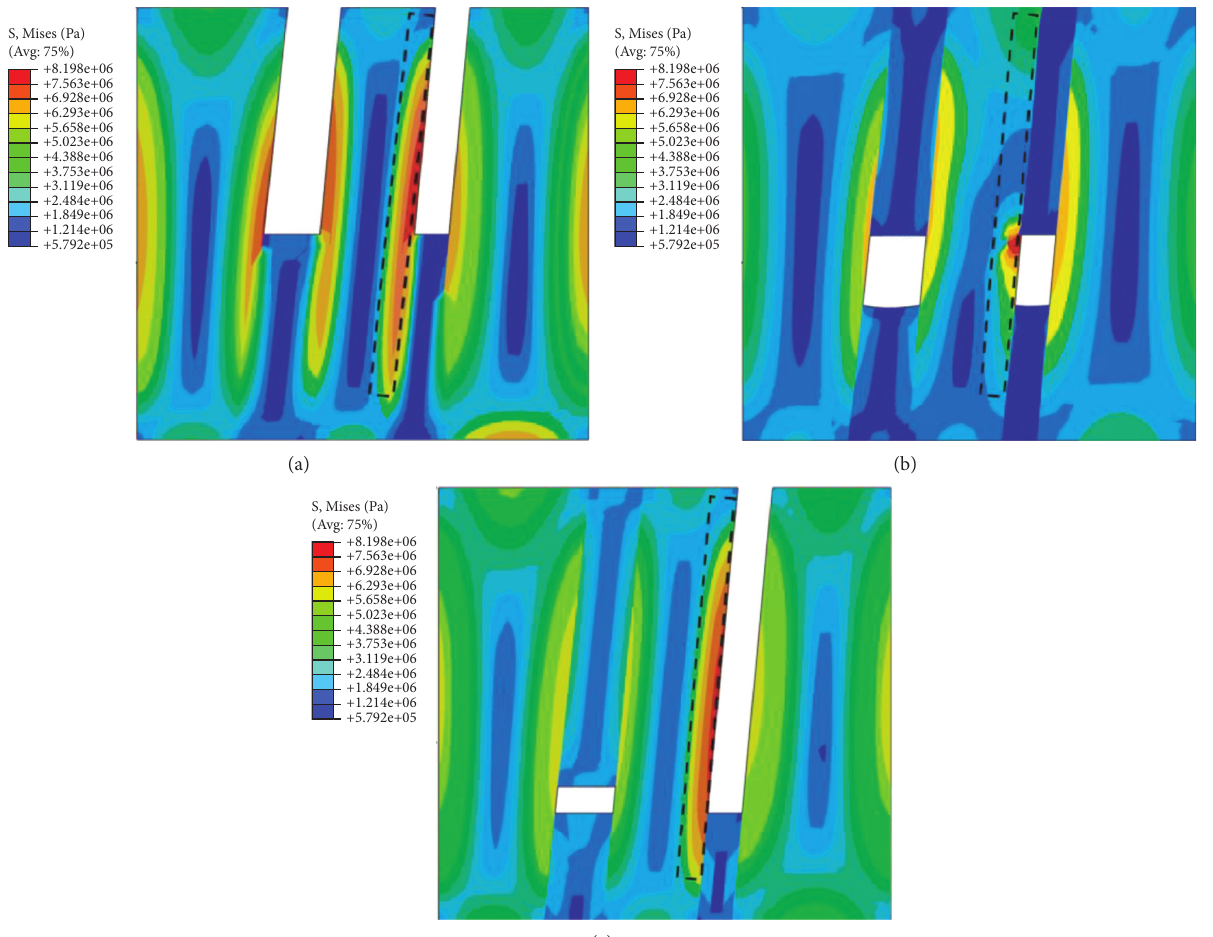
Figure 8: The stress distribution of the rock. (a) +590 m level. (b) +525 m level. (c) +500 m